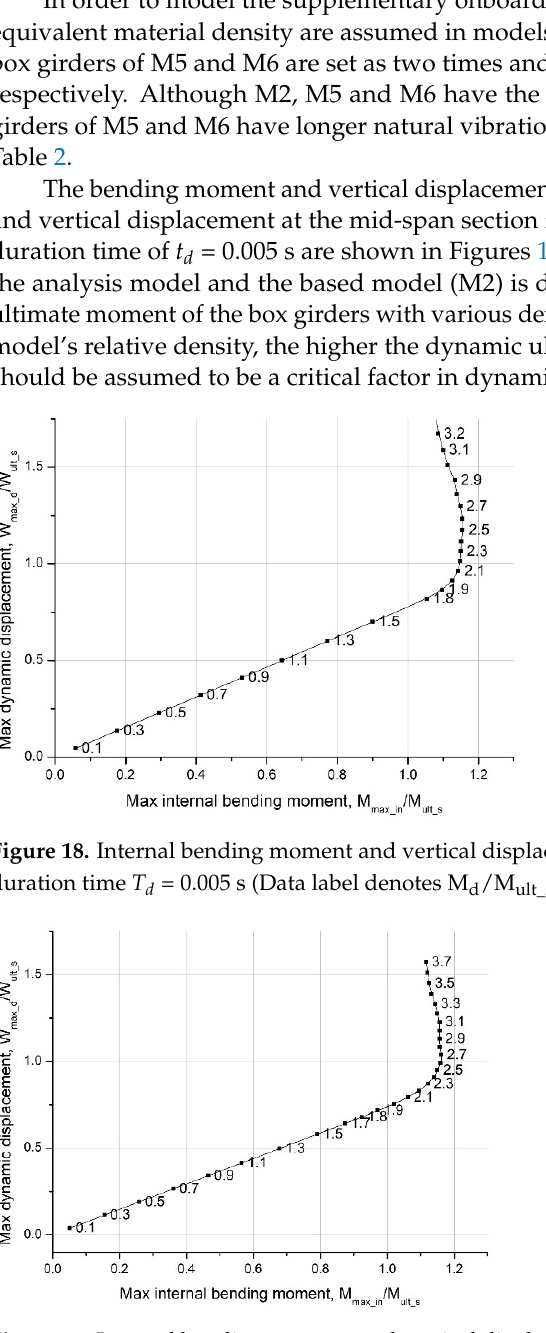
Figure 19. Internal bending moment and vertical displacement for mid-span box girder M6 at load duration time T d = 0.005 s (Data label denotes M d /M ult_s ).